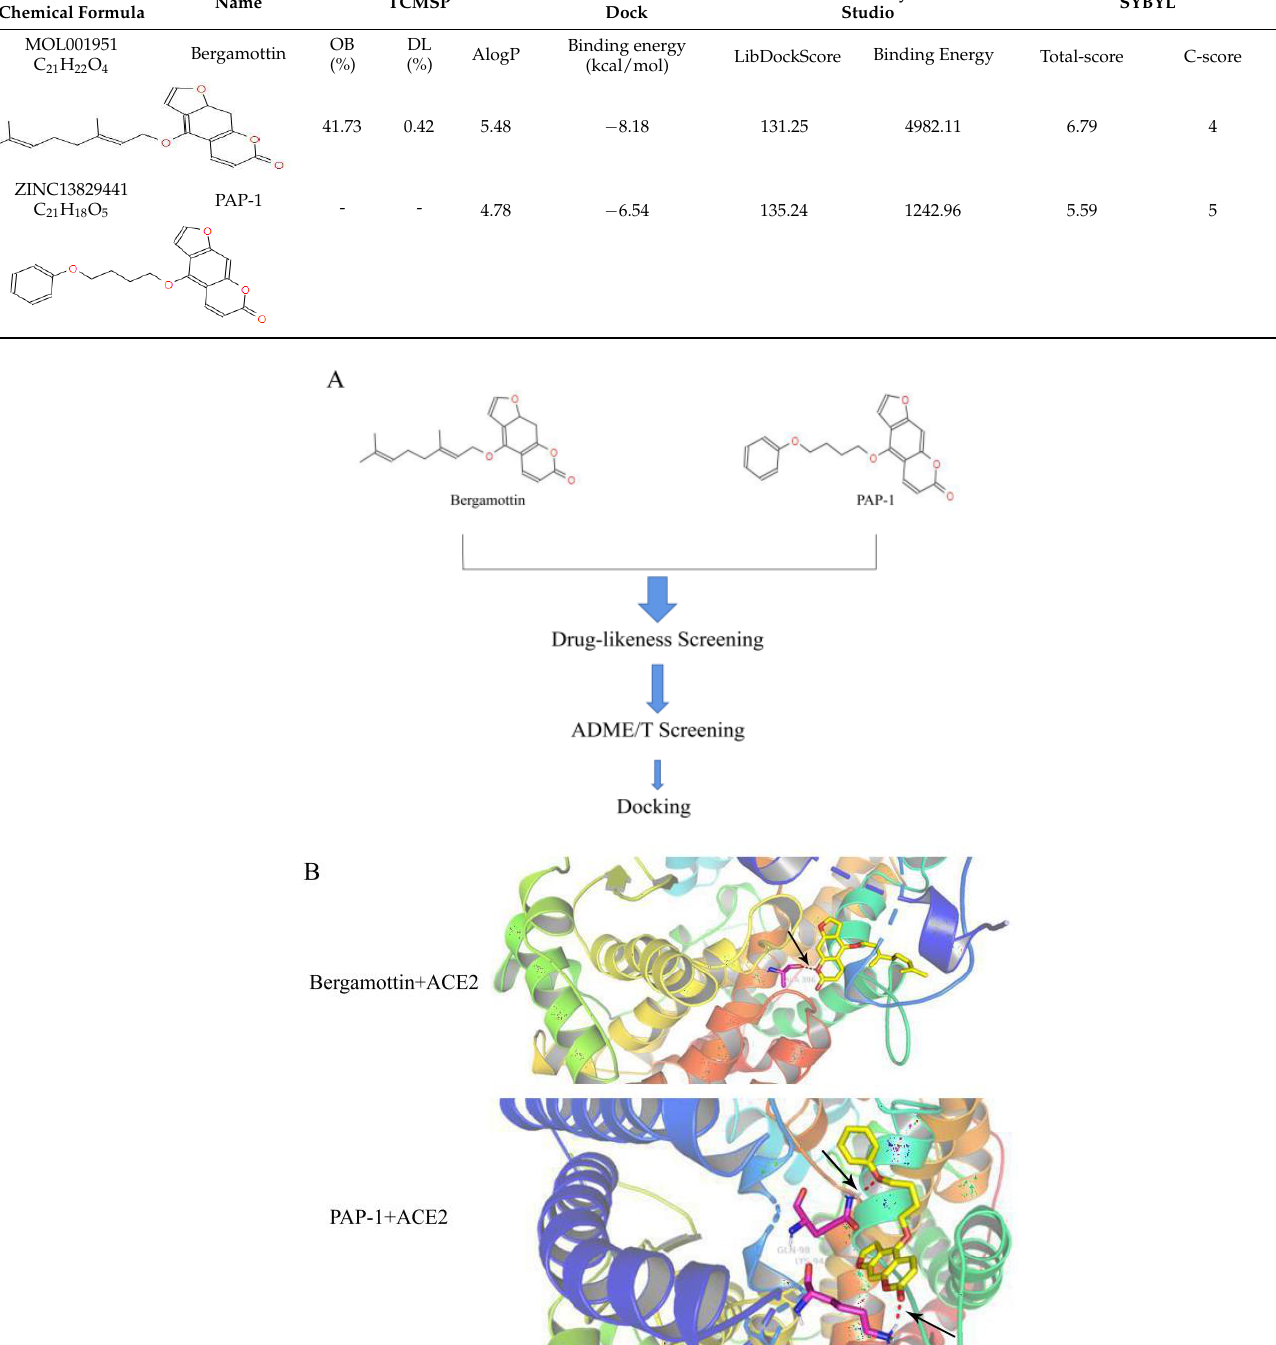
Table 1. Bergamottin and PAP-1 docking parameters.